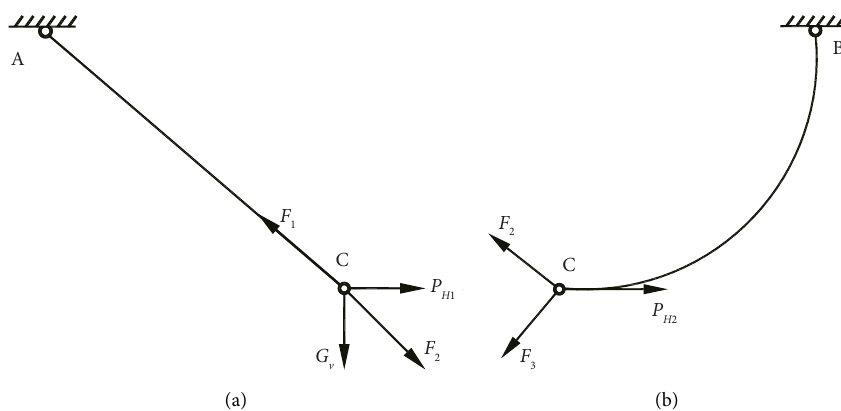
Figure 3: (a) Te mechanical analysis of the tension limb. (b) Te mechanical analysis of the compression limb.